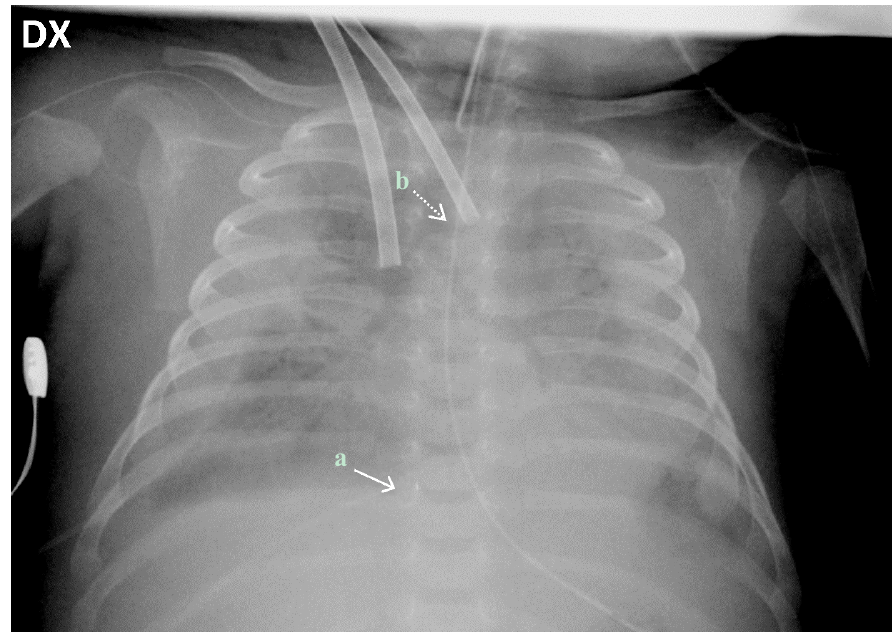
Figure 2. Chest X-ray of the patient 48 h after the start of ECLS support. Correct positioning of the ( a ) distal tip of the drainage cannula in the junction between the superior vena cava and the right atrium (straight white arrow) and ( b ) distal tip of the inflow cannula in the junction between the right common carotid artery and the aortic arch (dotted white arrow).